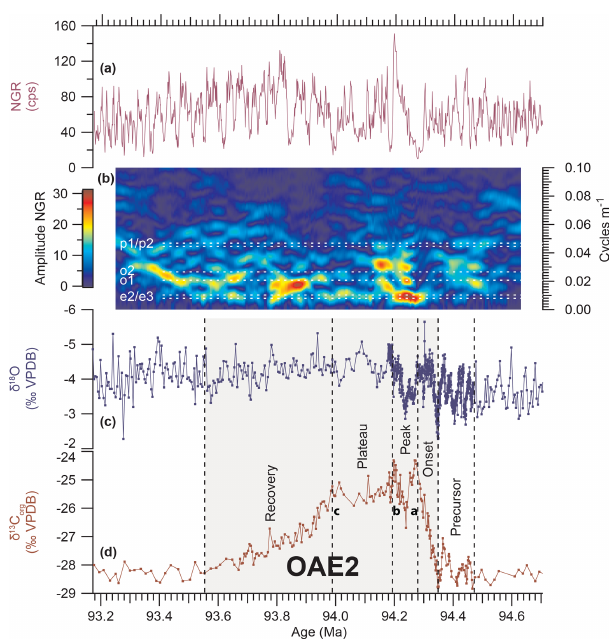
Figure 4. Identification of orbital periodicities across OAE1a using evolutive harmonic analysis (EHA) of natural gamma ray (NGR) data in La Bédoule Cores LB3–LB1. (a) NGR; purple dashed lines mark boundaries from segment N1 to N4 (Sect. S3 and Fig. S3.2); mean sedimentation rates given in brackets. (b) EHA plot of NGR; orbital periodicities are indicated by white dashed lines; eccentric- ity e1 (404kyr), e2 (124kyr) and e3 (95kyr), obliquity o1 (47kyr) and o2 (37kyr), precession p1 (22kyr) and p2 (18kyr) (Table S5.2). (c) δ 18 O and (d) δ 13 C carbonate from Lorenzen et al. (2013) and Moullade et al. (2015) with new high-resolution isotope data from this study. Carbon isotope stages C2–C8 of Menegatti et al. (1998) are indicated by red dashed lines. Individual phases (precursor, onset, peak, plateau, recovery) of OAE1a are separated by black dashed lines. Note: the EHA colour scheme is limited to 50% of the maximum amplitude to enhance visibility in the lower part of the core.